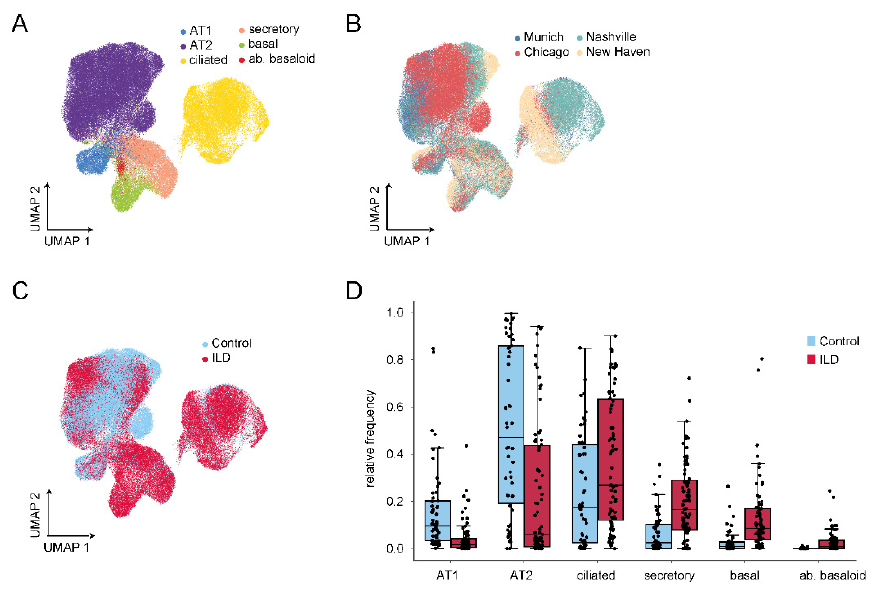
Figure 3. Single cell RNA-Sequencing has revealed drastic changes in epithelial cell populations in ILD. ( A ) Uniform Manifold Approximation and Projection (UMAP)-based dimension reduction of single cell transcriptomic data to delineate epithelial cell types, labelled by cell type. ( B ) Same UMAP visualization labelled by ILD cohort. Data used for visualization was derived from in total four datasets [42–45] of control and interstitial lung disease (ILD) samples: New Haven [45], Nashville [44], Chicago [42], and Munich [43]. ( C ) Same UMAP visualization labelled by disease. ( D ) Relative frequencies of epithelial cell populations demonstrate a consistent increase in conducting airway cell populations in ILD at the expense of alveolar type 1 (AT1) and 2 (AT2) cells. ab., aberrant.